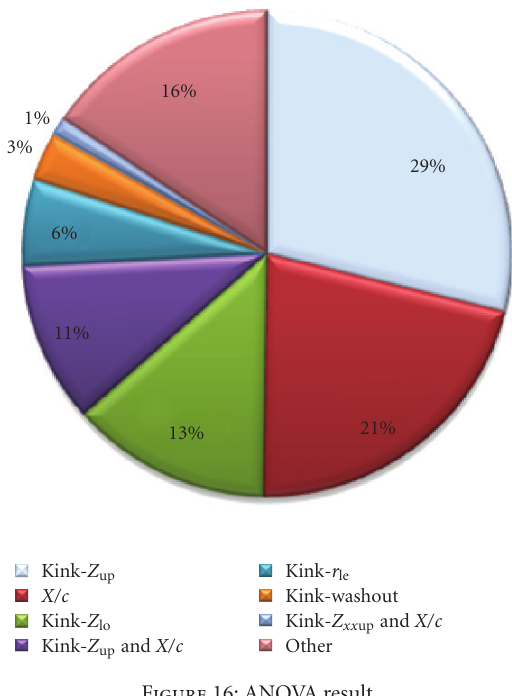
Figure 16: ANOVA result.